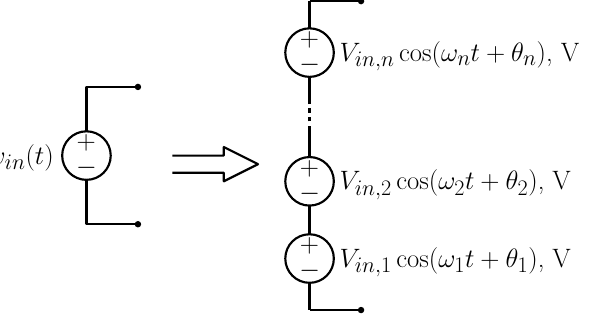
Figure 14. Equivalent electrical two terminal element representation for a multi-periodic